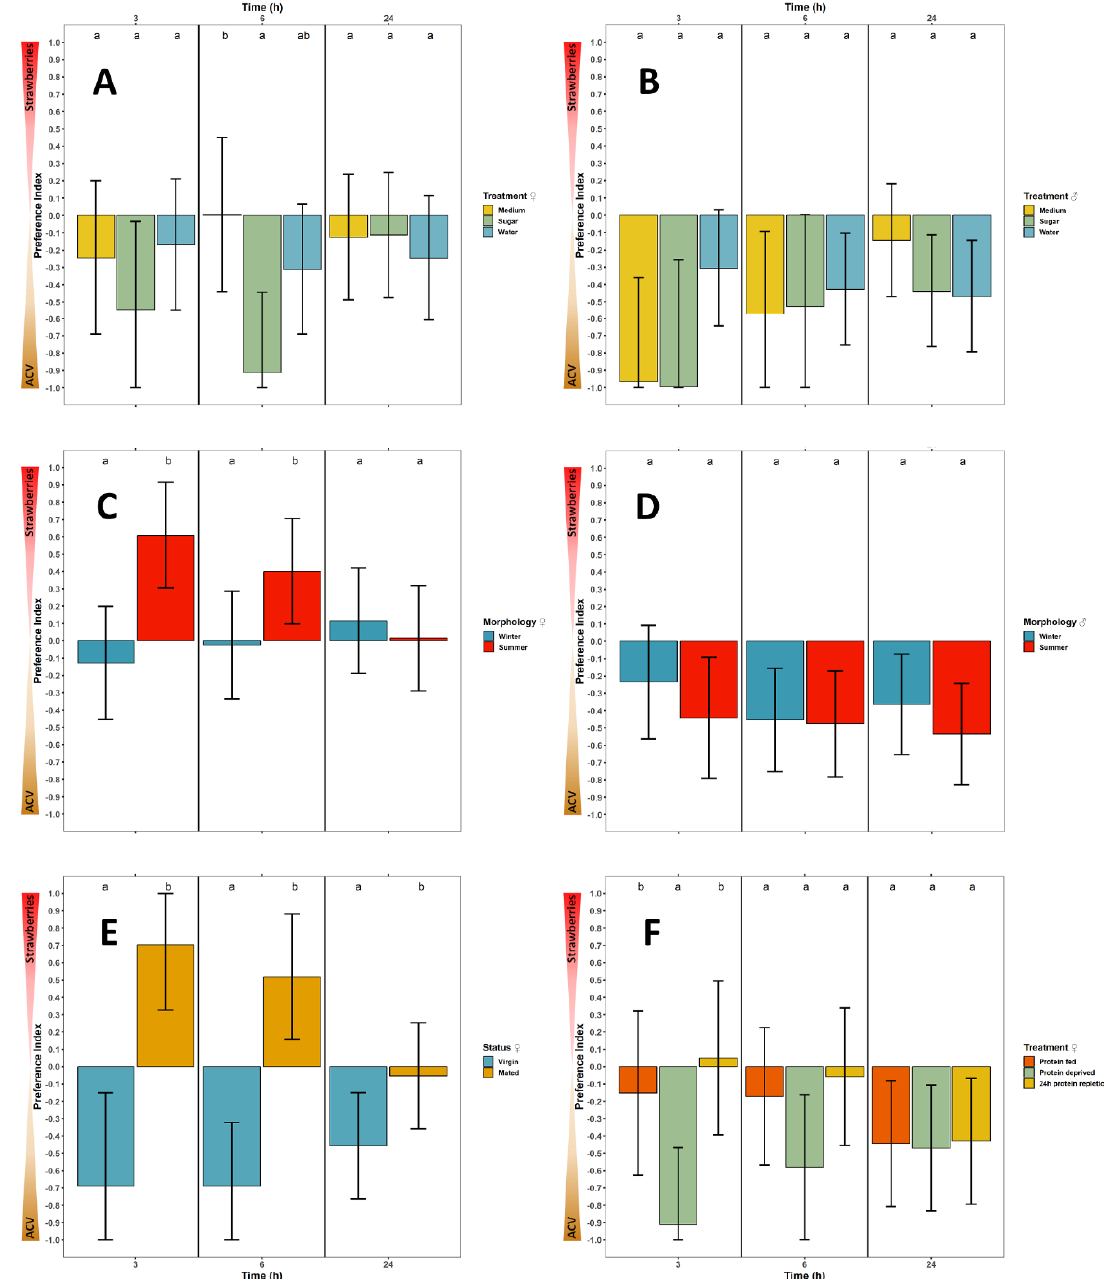
Figure 3. The e ff ect of physiology on the preference of D. suzukii between apple cider vinegar (ACV) and strawberries is investigated in olfactometer experiments focused on: ( A ) Females of di ff erent feeding status, ( B ) males of di ff erent feeding status, ( C ) females of di ff erent seasonal morphology, ( D ) males of di ff erent seasonal morphology, ( E ) females of di ff erent mating status and ( F ) females of di ff erent reproductive status, acquired with di ff erent diet treatments. Bar graphs show the estimated marginal mean and confidence interval of the preference index. When exceeding the theoretical interval [ − 1,1], the confidence interval is cropped to its maximum (minimum) level. Di ff erent letters denote significant di ff erences between